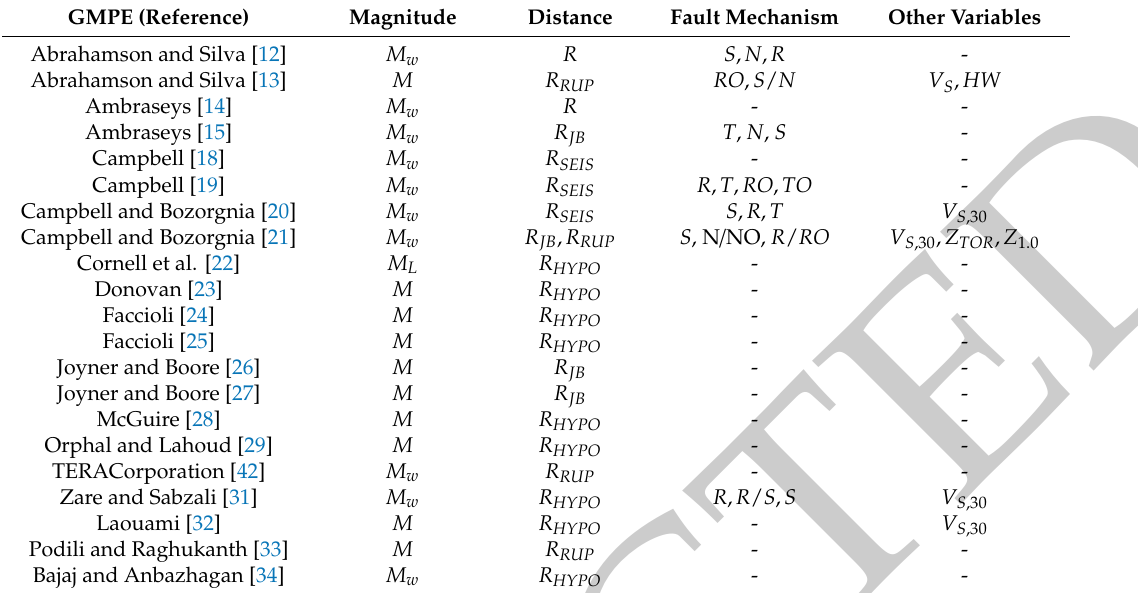
Table 1. Variation of GMPE